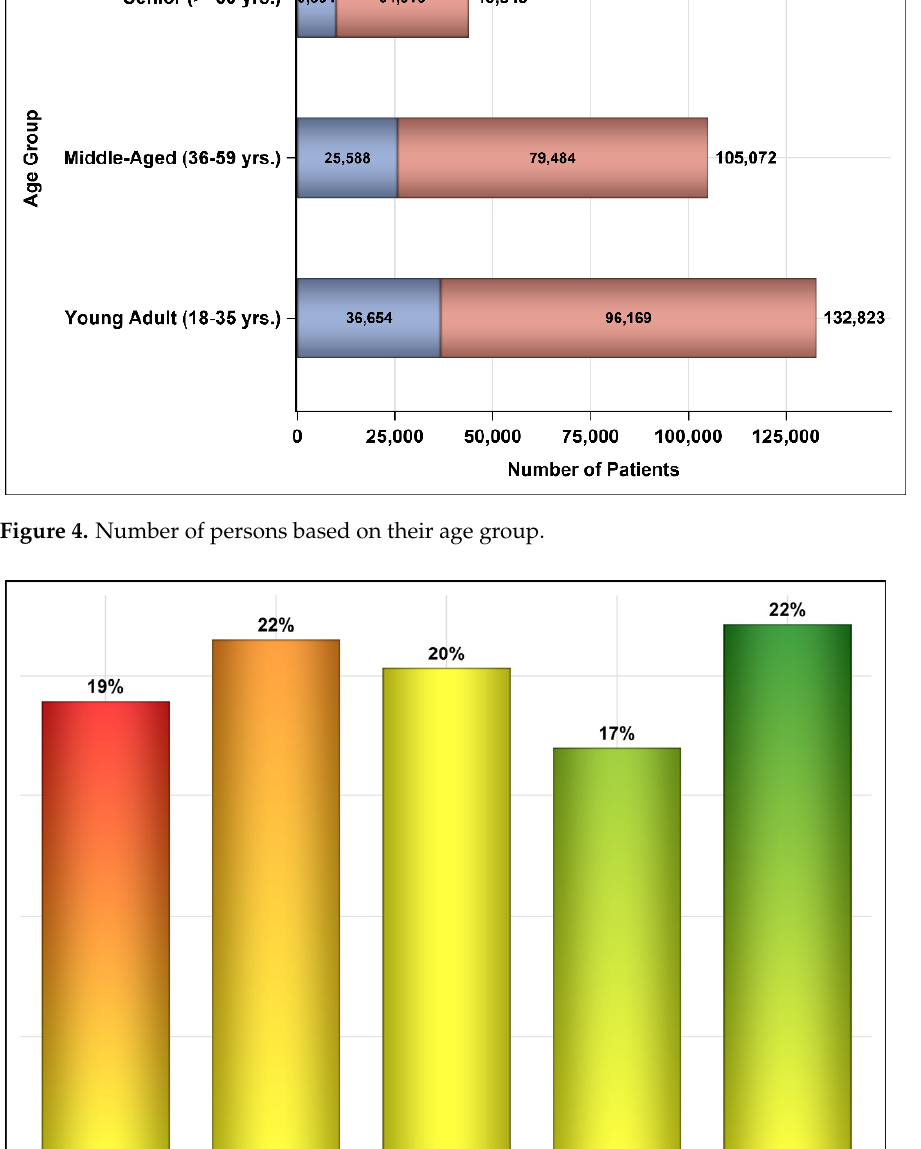
Figure 4. Number of persons based on their age group.